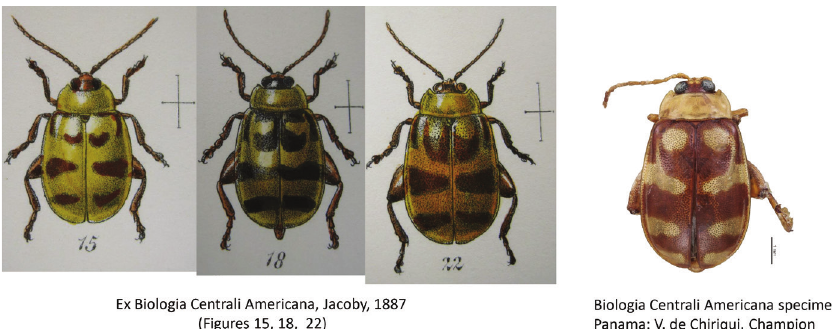
Figure 14. Alagoasa decemguttata (Fabricius) intraspecific